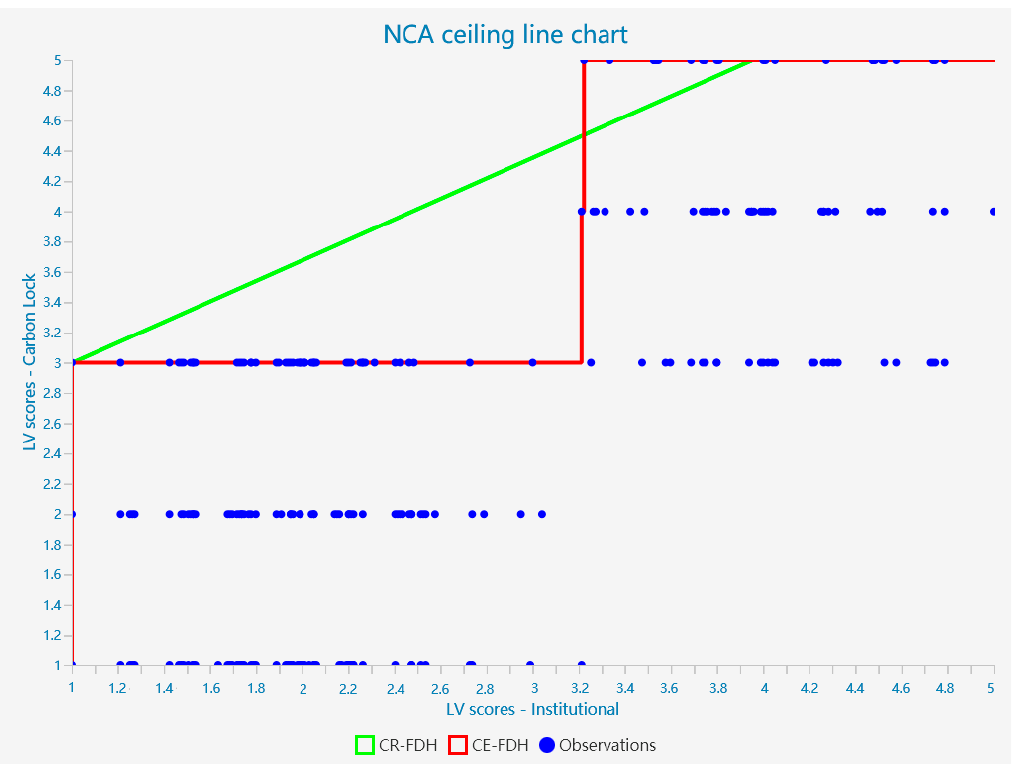
Figure 4. Scatterplot of the analysis of the necessity of technical factors for carbon unlocking.